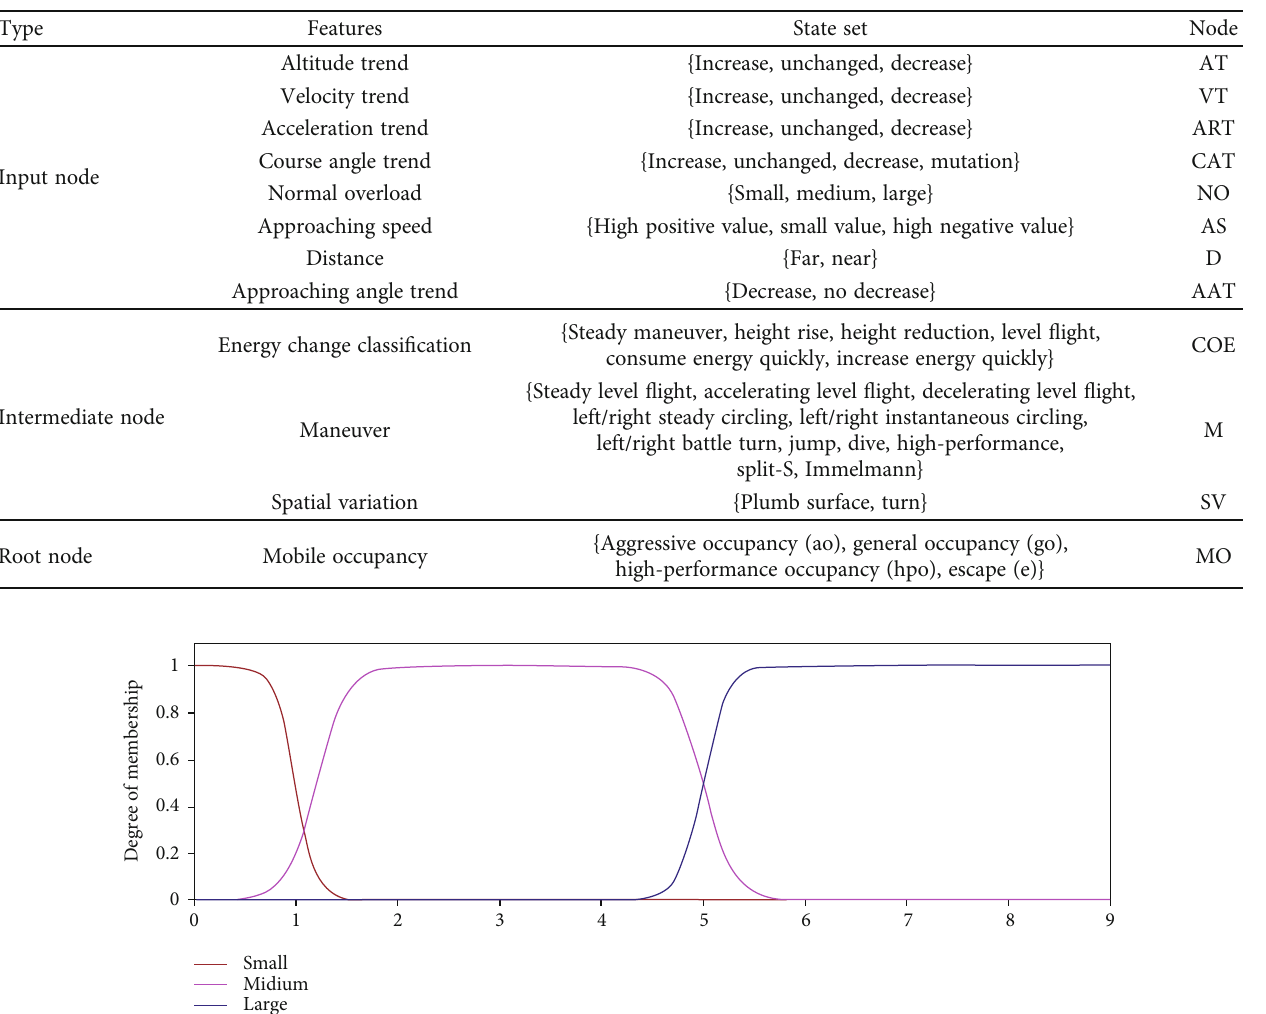
Table 1: The de fi nition of network